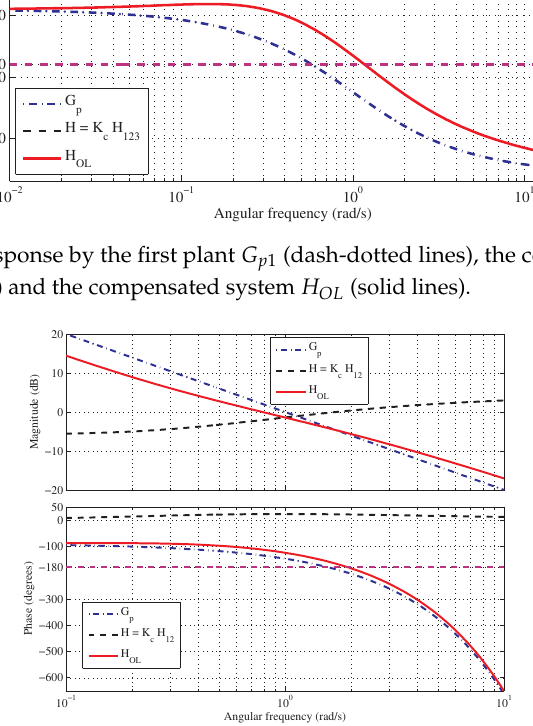
Figure 8. Frequency response by the second plant G p 2 (dash-dotted lines), the compensator H with the CS-FLEC (dashed lines) and the compensated system H OL (solid